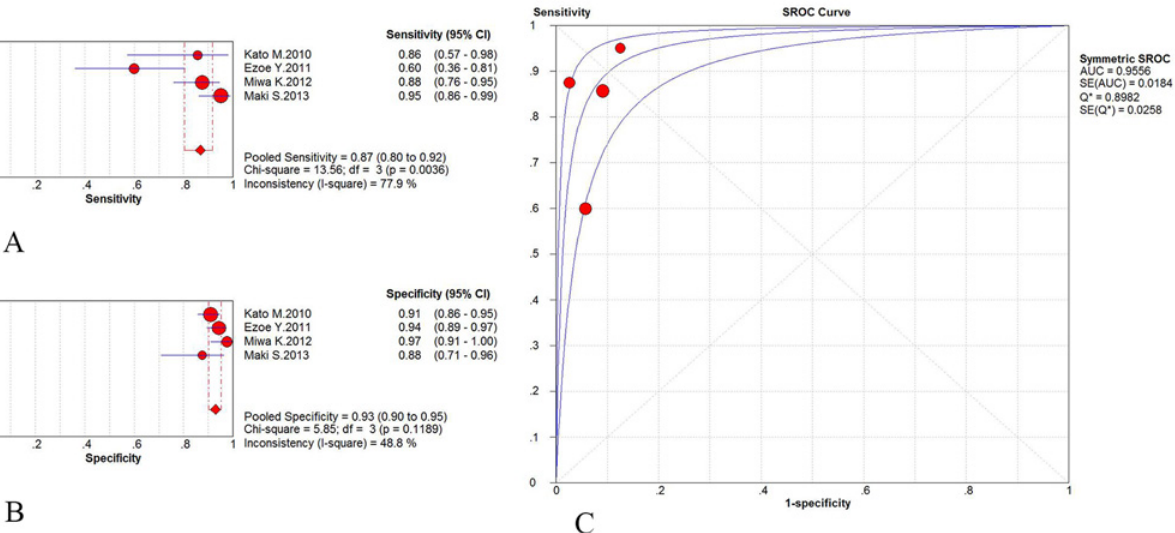
Fig 3. ME-NBI results from the subgroup analysis performed to evaluate the diagnostic efficacy of ME-NBI vs. WLI. A: Pooled sensitivity of ME-NBI in the subgroup analysis. B: Pooled specificity of ME-NBI in the subgroup analysis. C: Symmetric receiver operating characteristic (SROC) curve and area under the curve (AUC).